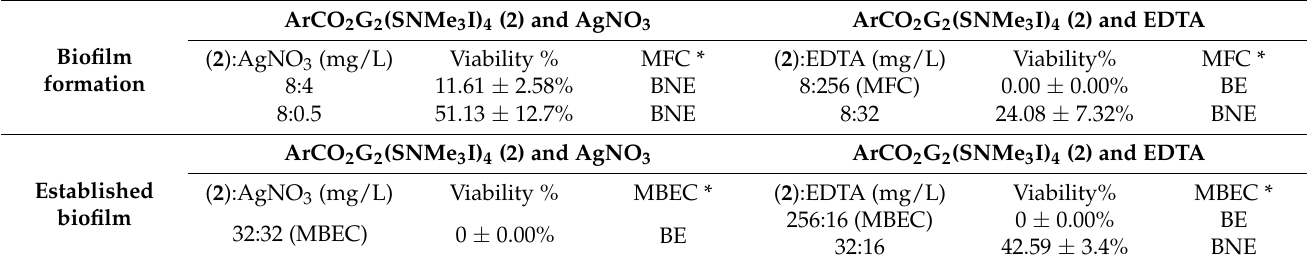
Table 2. Viability percentage of cells forming Candida biofilms. The minimum fungicidal concentration (MFC) and minimum biofilm eradicating concentration (MBEC) values for the different combinations of ArCO 2 G 2 (SNMe 3 I) 4 ( 2 ) -AgNO3 and ArCO 2 G 2 (SNMe 3 I) 4 ( 2 ) -EDTA are